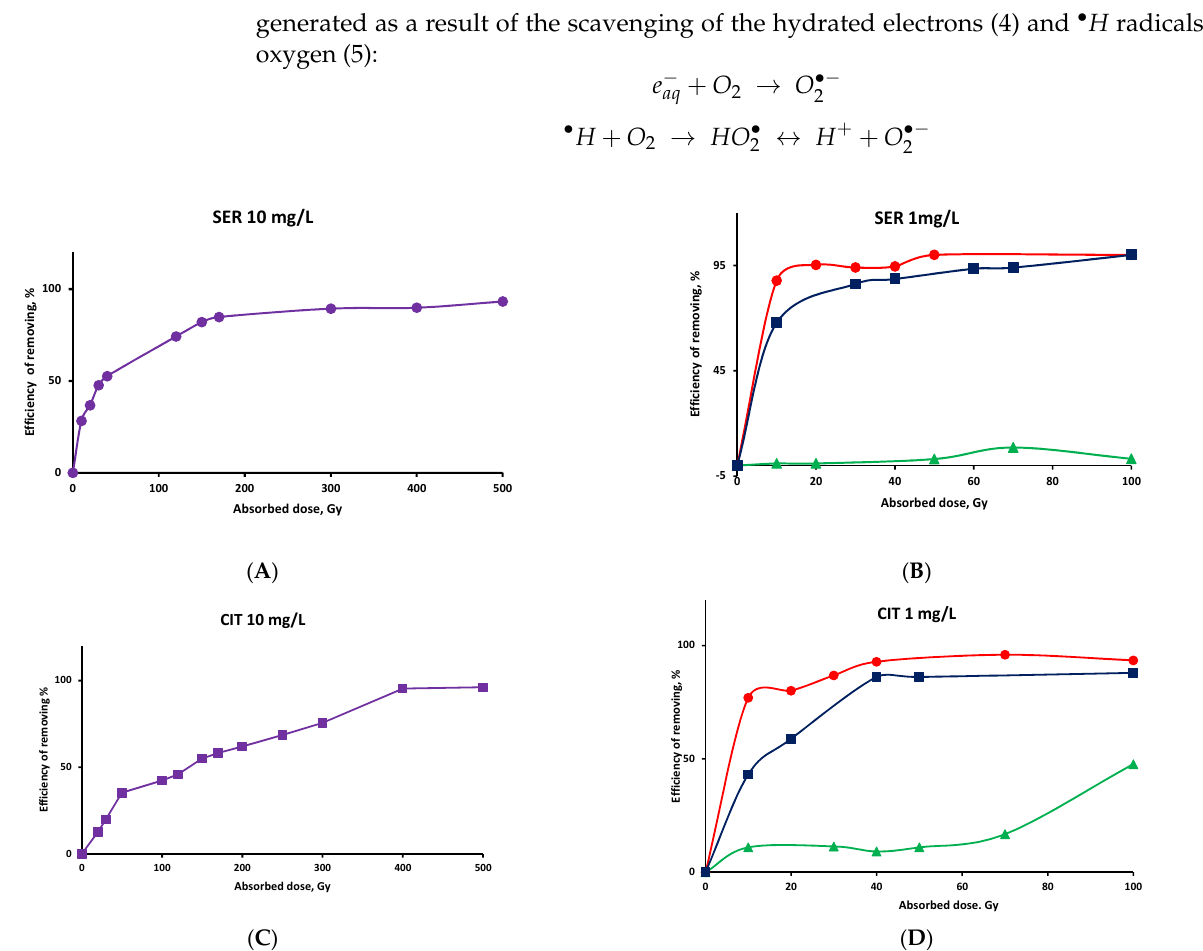
Figure 1. Efficiency of removing ADs from aqueous solution using gamma radiation under different conditions: ( A ) 10 mg/L sertraline, ( B ) 1 mg/L sertraline and ( C ) 10 m/L citalopram, ( D ) 1 mg/L citalopram. Conditions of irradiation: ( ) solution saturated with argon in the presence of t- butanol at pH 7-solvated electrons predominate, ( ● ) solution saturated with N 2 O • OH radicals